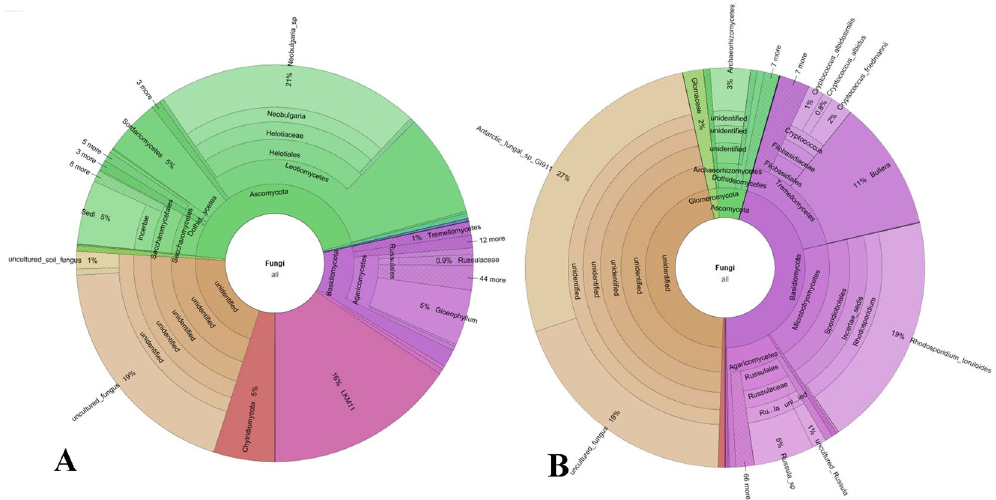
Figure 3. Krona pie chart plots of the fungal communities proportional abundances (%) in the shallow (41 cm of depth) ( A ) and in the deep (279 cm of depth) ( B ) peat